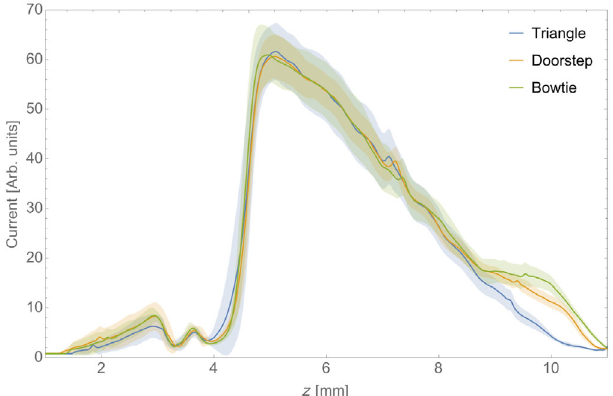
FIG. 7. Post-EEX current profiles for the triangle, doorstep, and bowtie masks, shown with shaded bands that correspond to one standard deviation after normalization and alignment. The names in the legend identify the shape of the MLC mask, not necessarily the final beam